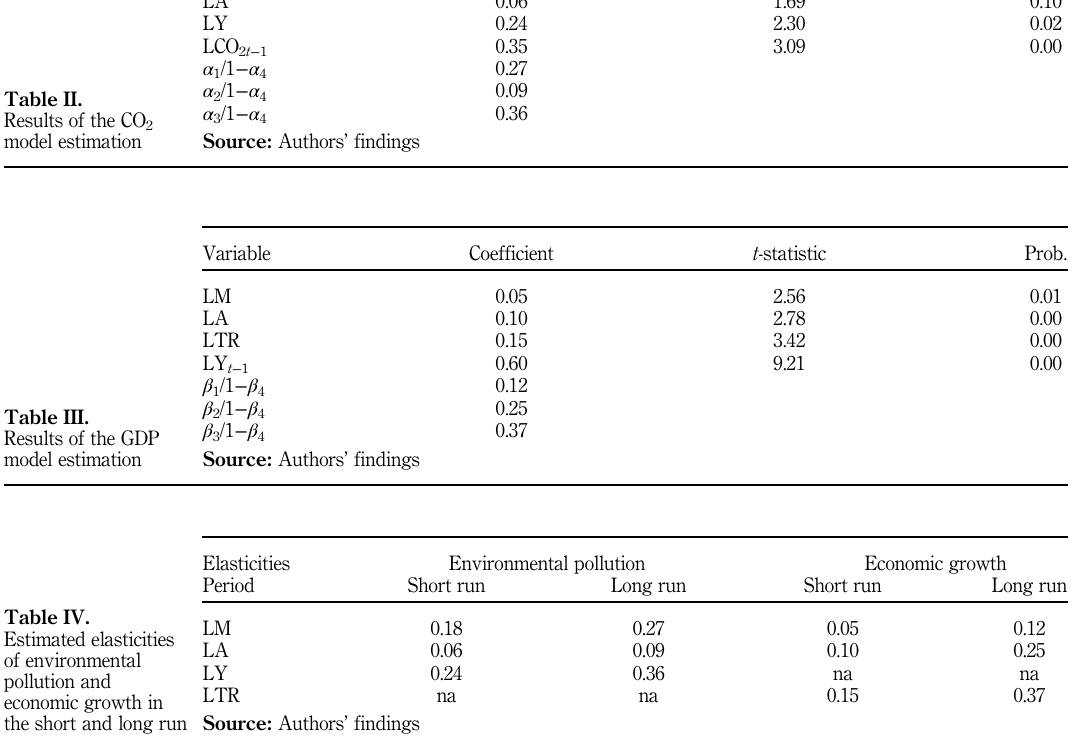
Table IV. Estimated elasticities of environmental pollution and economic growth in the short and long